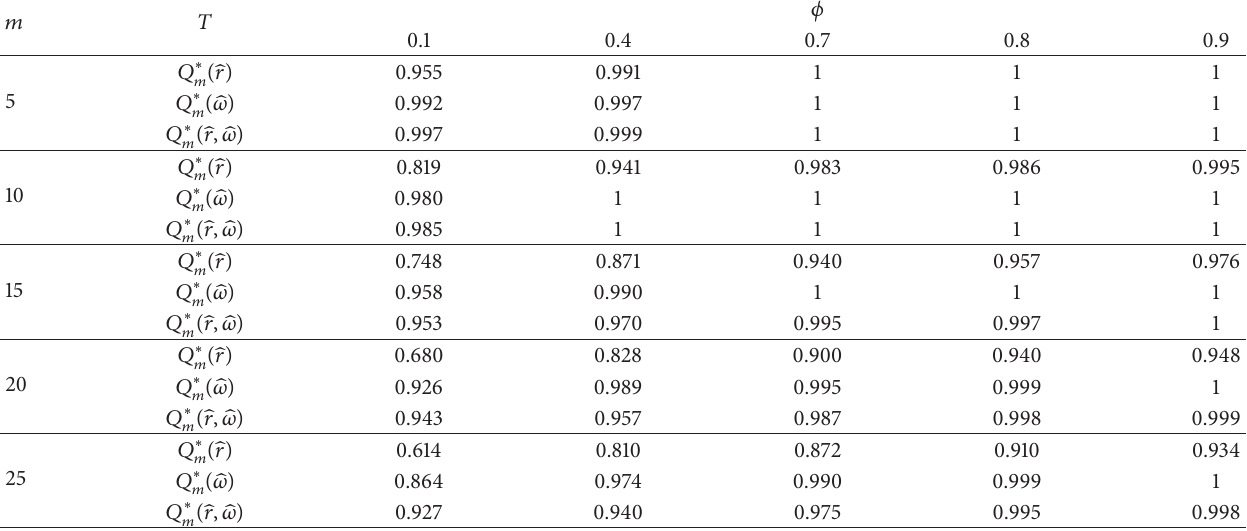
Table 4: Empirical power by fitting an AR (1) process against an ARMA (1,1) process: 𝑦 𝑡 = 𝜙𝑦 𝑡−1 + 𝜀 𝑡 + 0.8𝜀 𝑡−1 using 1000 Monte Carlo runs.